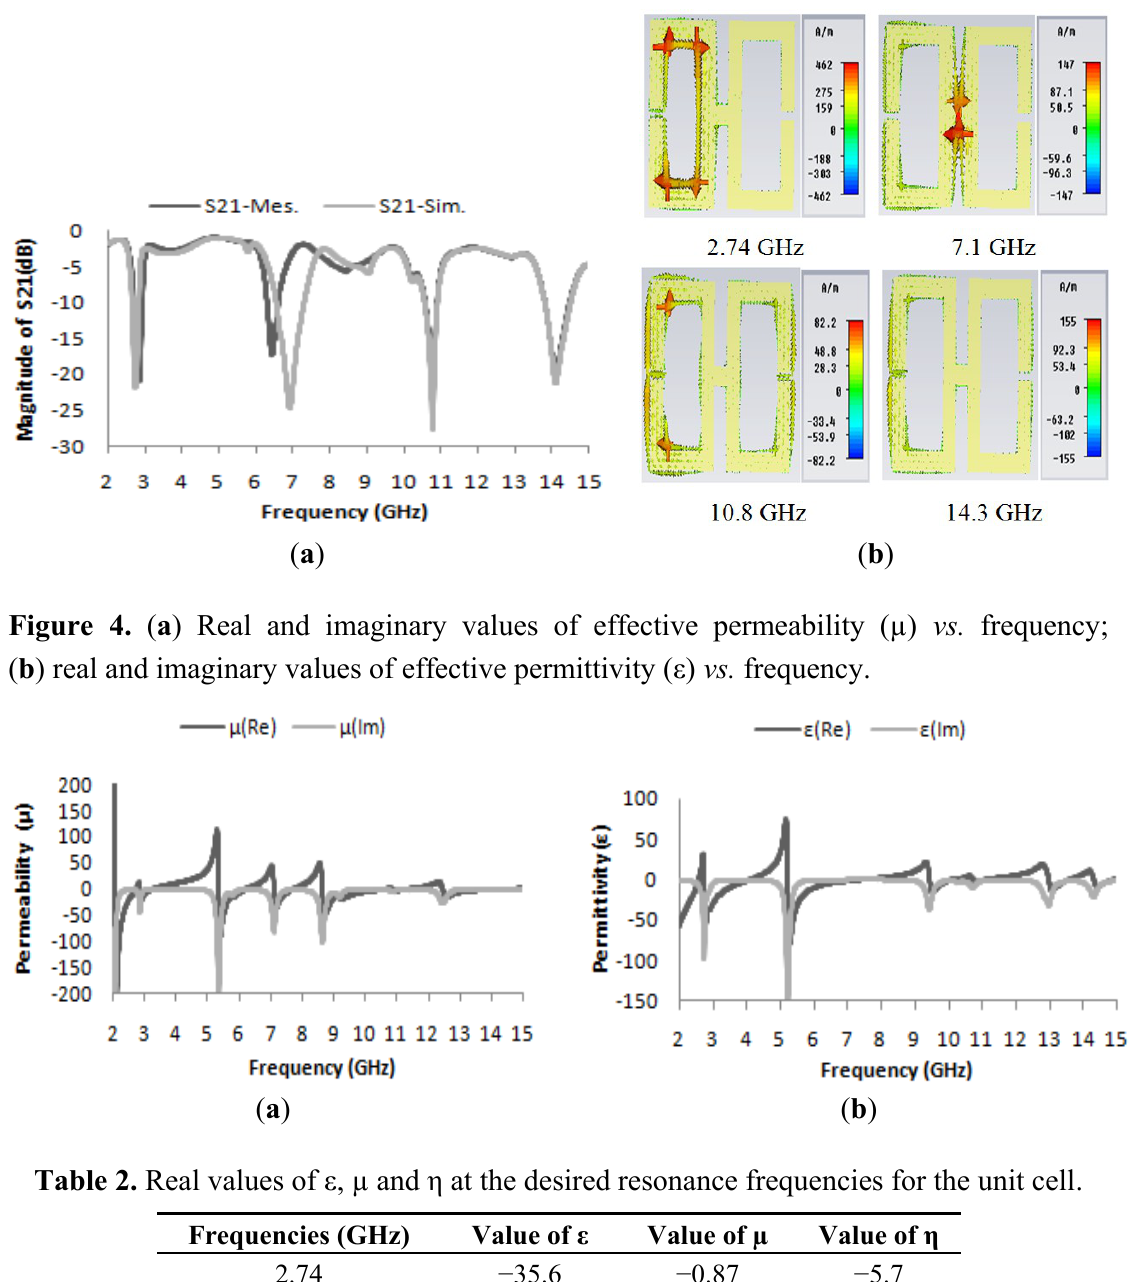
Figure 3. ( a ) Magnitudes of the measured and simulated transmission parameters (S units of dB for the unit cell; ( b ) current distributions in the unit cell structure at various frequencies.